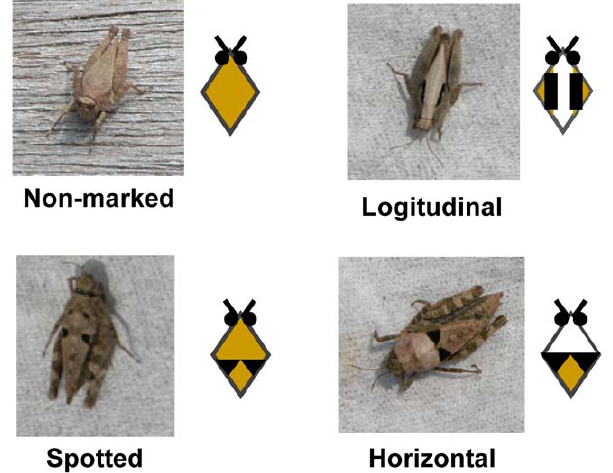
Figure 1. Morphs of pygmy grasshoppers ( Tetrix japonica ) classified by type of markings. Pygmy grasshoppers ( Tetrix japonica ) used in the experiments.